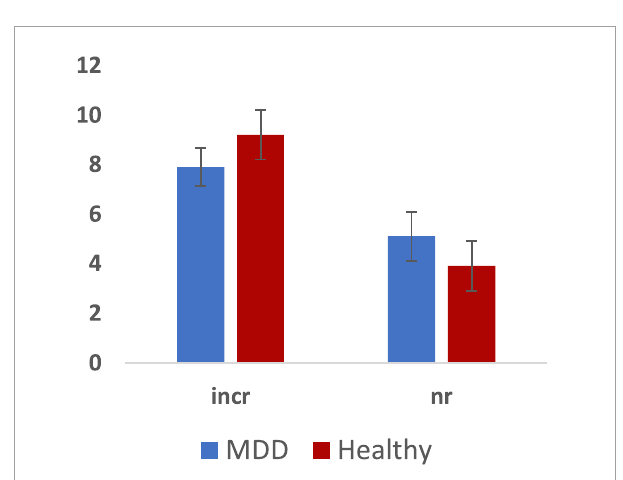
FIGURE3 Total errors across MDD and Healthy groups (Mean ± SE): incorrect responses (incr) and non-response